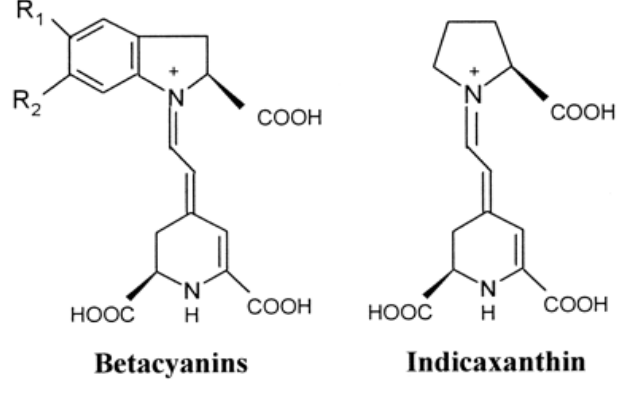
Figure 1. Structures of the principal betacyanins (betanidin and betanin) ( left ) and the betaxanthin indicaxanthin ( right ) in O. ficus-indica (L.) Mill. fruits, predominant in the purple and orange variety,